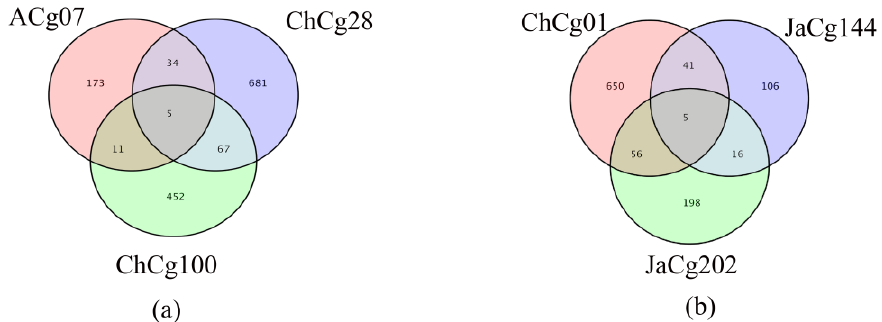
Figure 5. Venn diagram of total DEGs in six isolates of Cenococcum geophilum after 30 ◦ C treatment as compared to the same isolates cultured in normal conditions (25 ◦ C). DESeq2_EBSeq, p value = 0.05 and |log2 (fold change)| ≥ 0.58 were used as the screening criteria of DEGs. ( a ) three tolerant isolates DEGs, ( b ) three susceptible isolates DEGs.